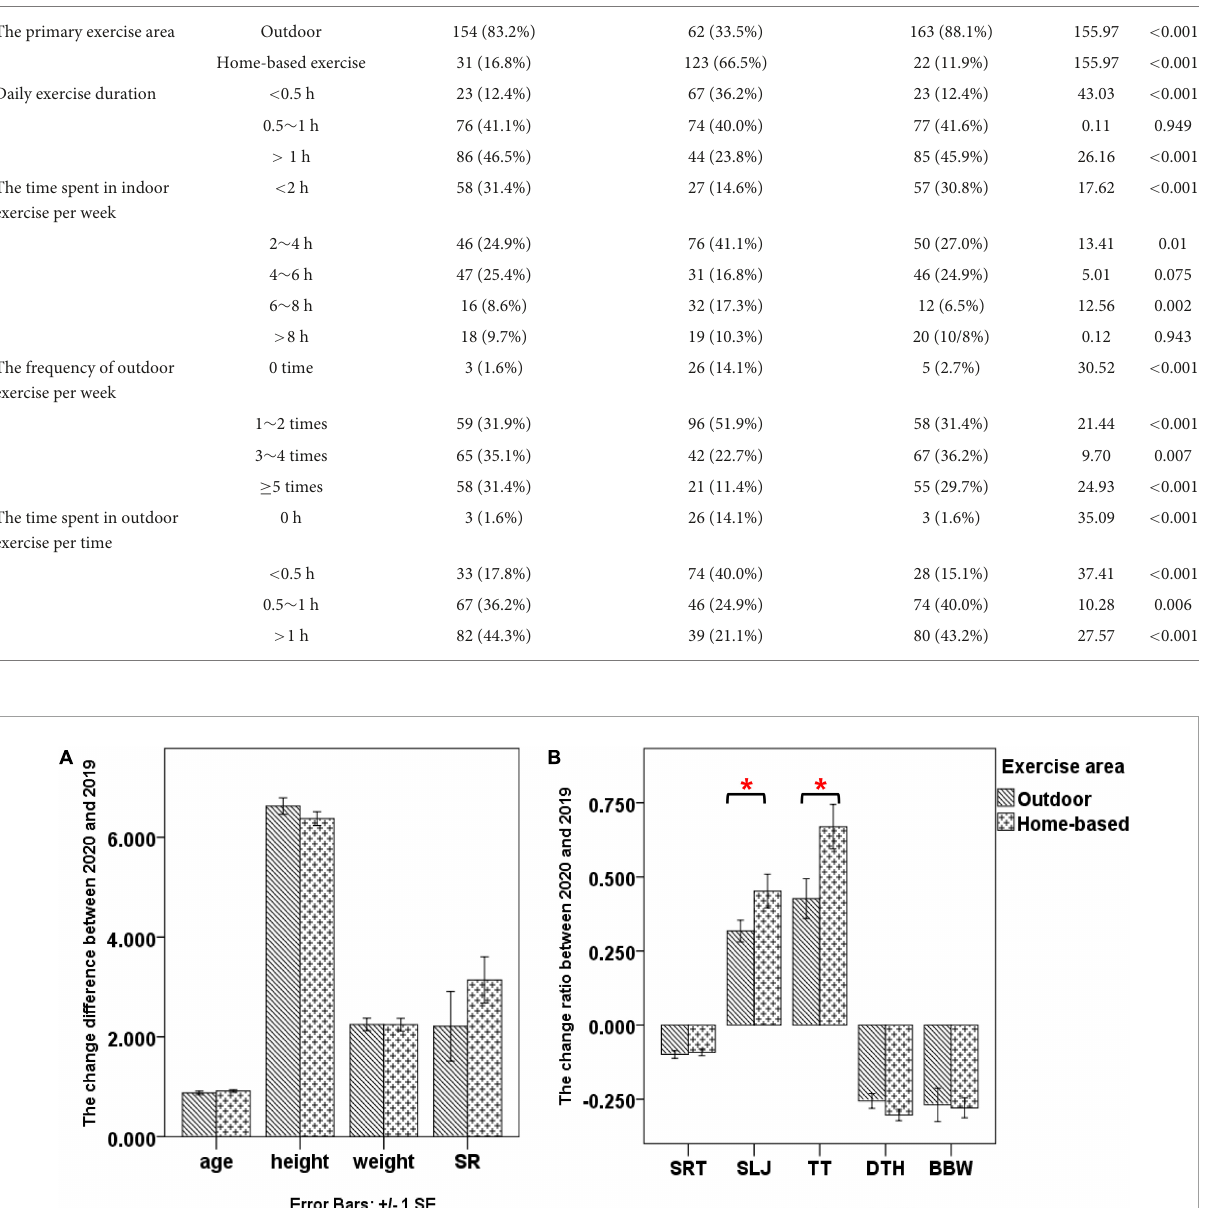
power, muscle coordination, and body flexibility, which was likely related to the home-based exercise during COVID-19 school closure. The enhancement in muscle strength, muscle